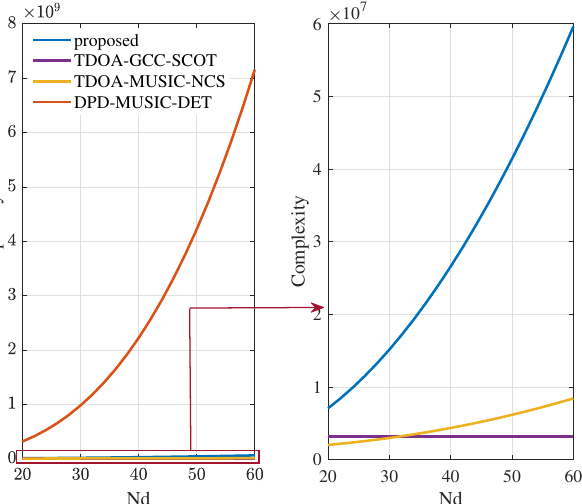
Figure 3. Variation curves of complexities of different methods with N d .